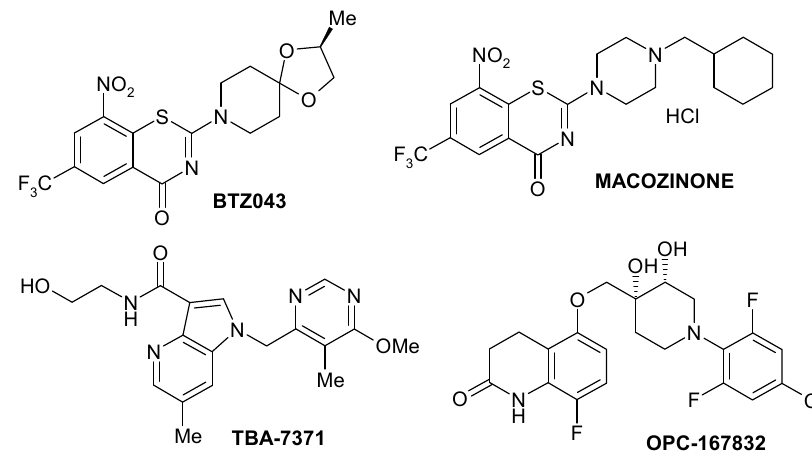
Figure 1. DprE1 inhibitors in clinical development 55